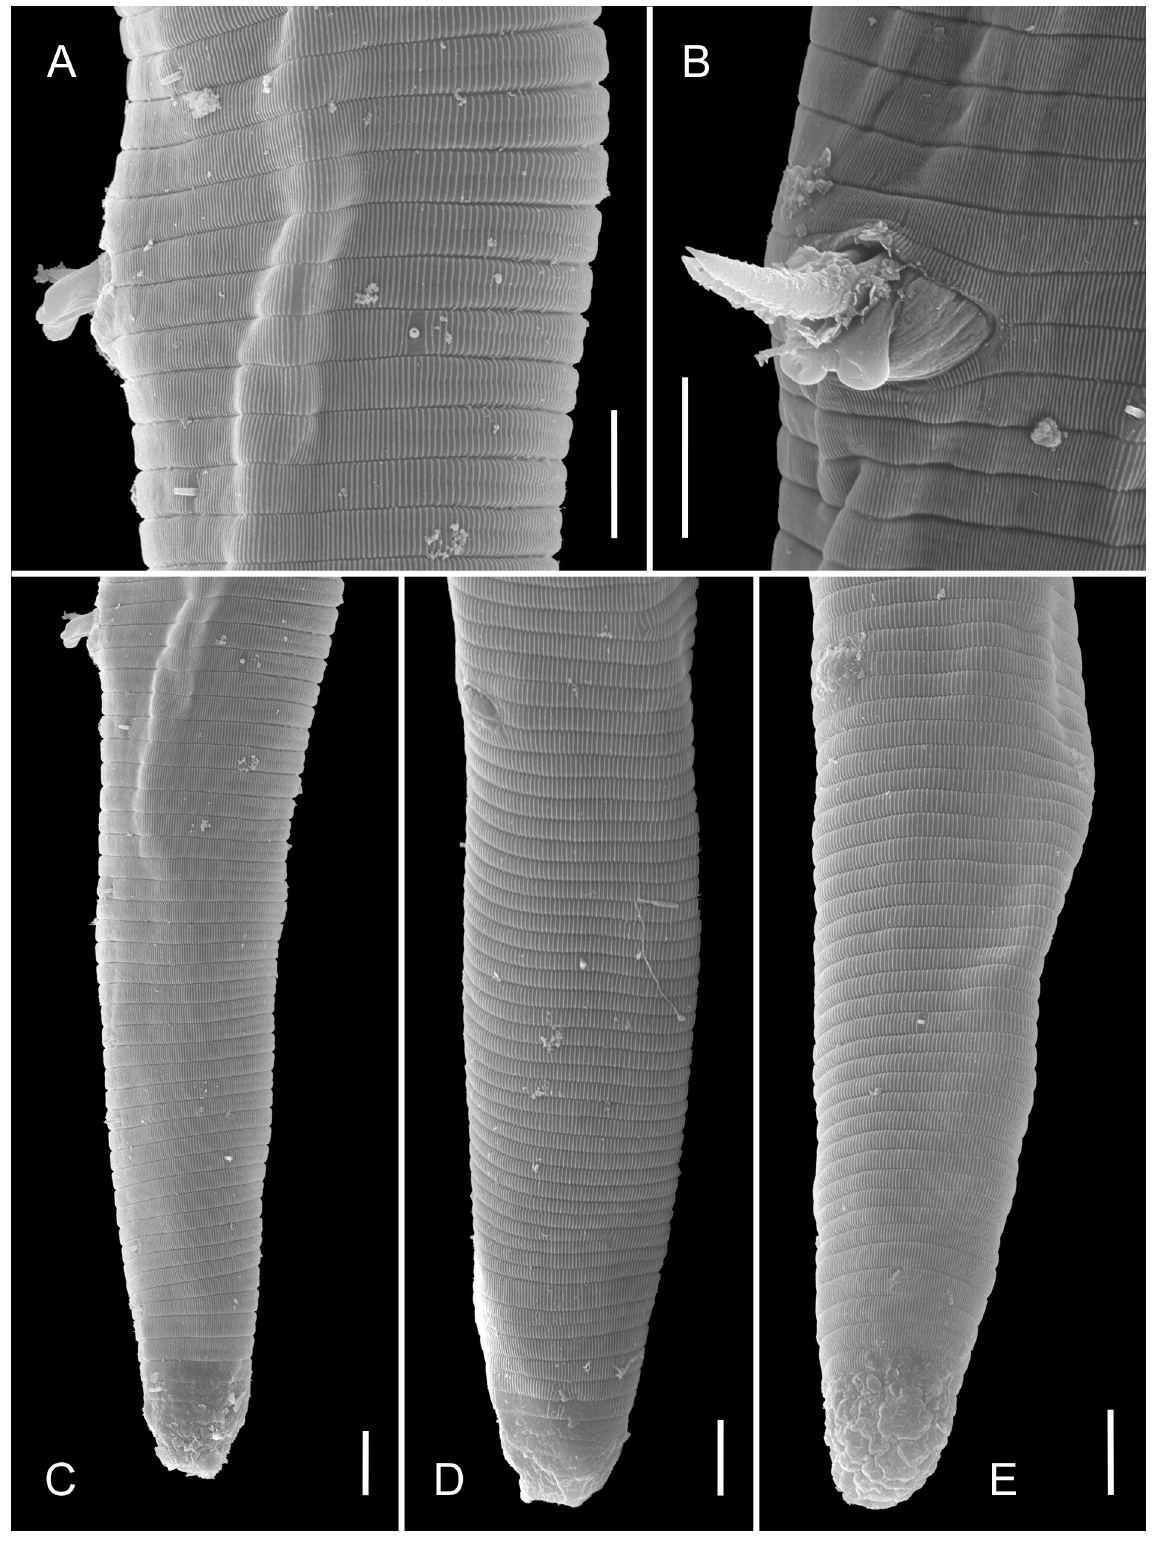
Fig. 3. Diplopeltoides suecicus sp. nov. SEM micrographs. A . Male cloacal region, lateral view. B . Male cloacal region, ventrosubventral view. C . Male tail, lateral view. D–E . Female tail, ventrosublateral view. Scale bars: A–E = 5